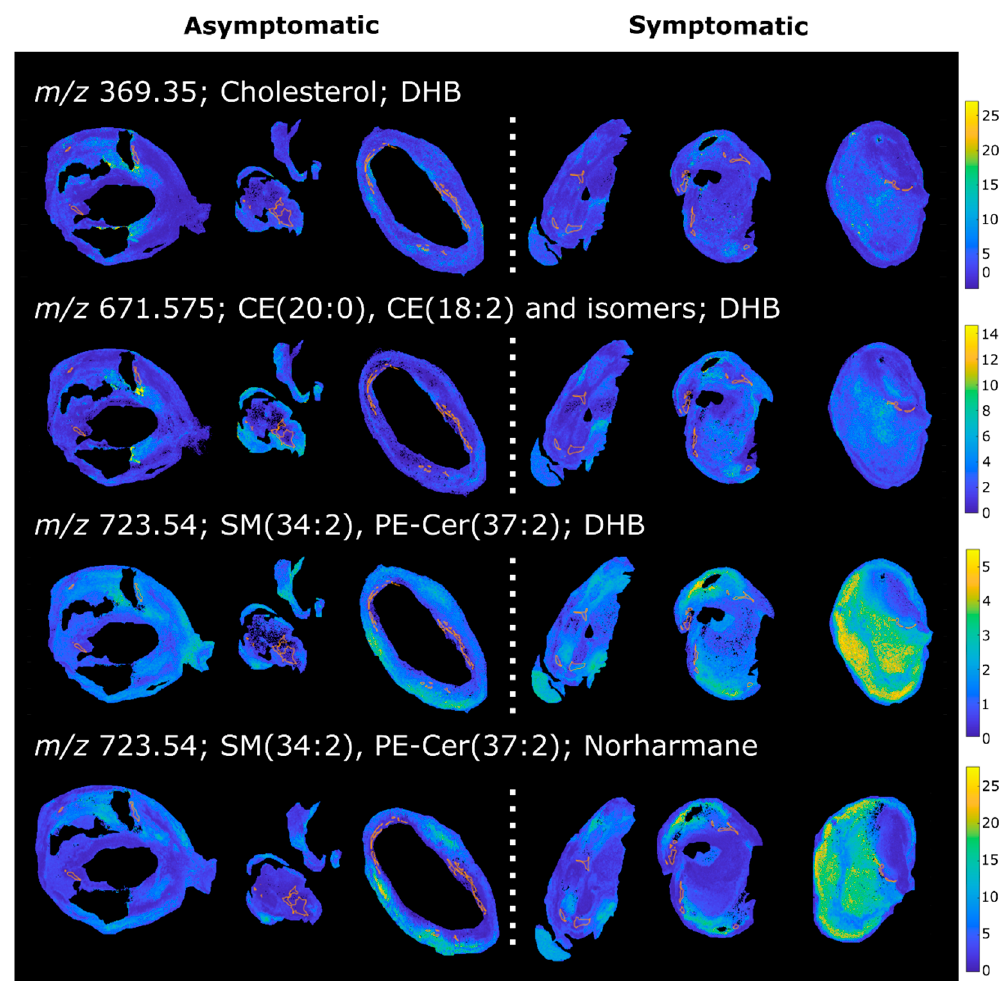
Figure 5. MALDI images of a selection of lipids upregulated in the macrophage area in symptomatic plaques. Macrophage-rich regions are highlighted.